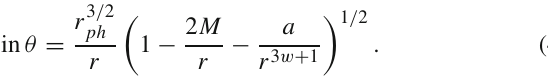
Fig. 6 Observationalappearancesofageometricallyandopticallythin disk with different profiles near black hole with M = 1, a = 0 . 05, w = − 0 . 7, viewed from a face-on orientation. The left column shows the profiles of various emissions I em ( r ) . The middle column exhibits